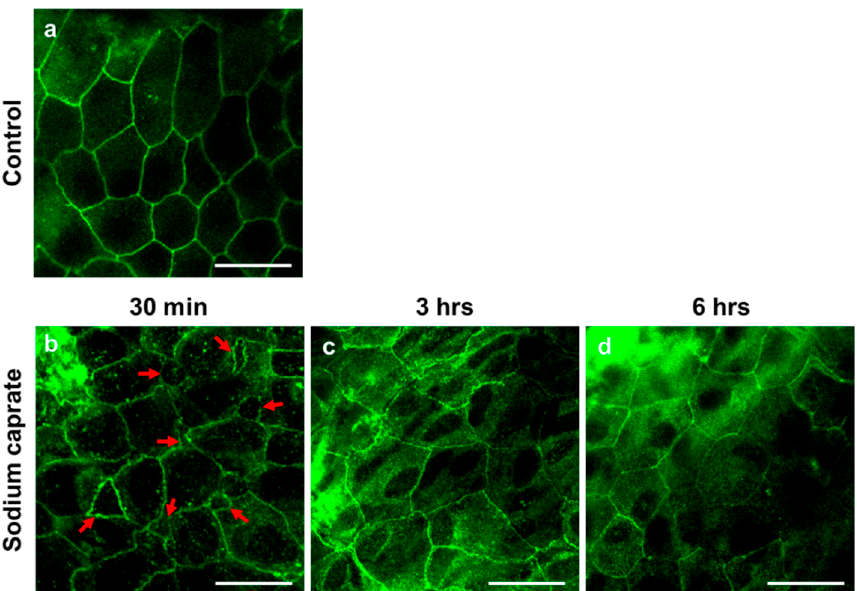
Figure 2. Representative confocal microscopy images of the cochlear round window membrane obtained from untreated (control) or sodium caprate-treated rats. Whole mounts of cochlear RWM were stained with zonula occludens protein 1 (ZO–1, also known as tight junction protein–1, green fluorescence) antibody. ( a ) Control (untreated) rats showed no gaps between cells of RWM outer epithelial layer which create ”regular” pentagonal or hexagonal patterns on the surface. ( b – d ) Sodium caprate–treated animals presented irregular contours and gaps (red arrows) at 30 min ( b ), 3 h ( c ) and 6 h ( d ) post-sodium caprate administration. n = 2. Scale bar = 20 µ m. All images were photographed from the middle ear